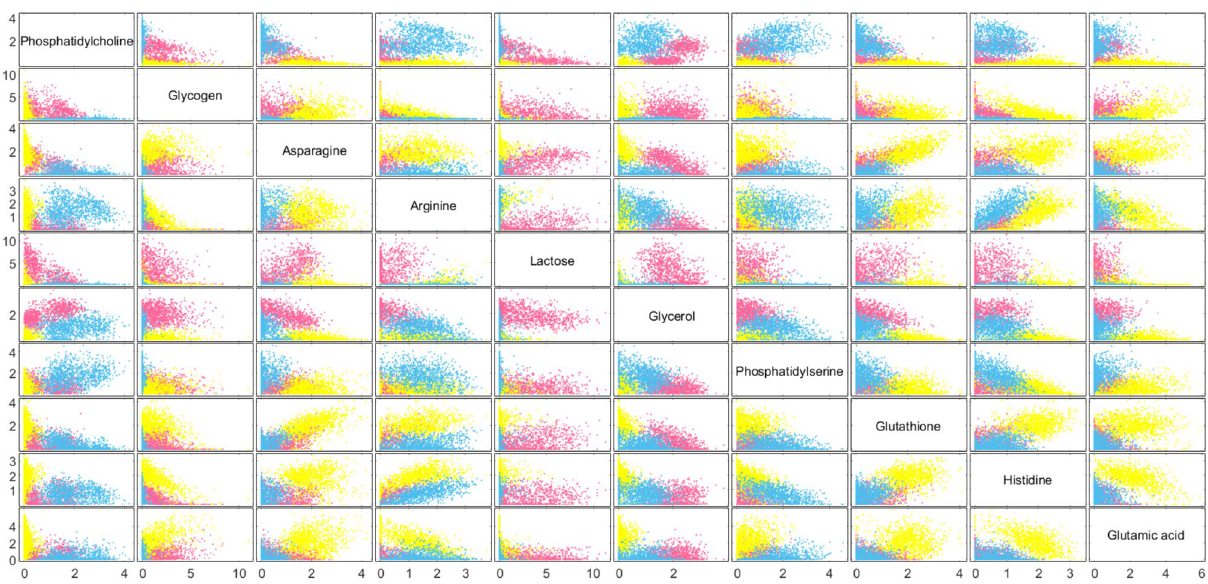
Figure 5. Scatter plot depicting scores for each cell line H460 (pink), MCF7 (yellow) and LNCaP (blue) on the 10 most important chemicals obtained from random forest decision modelling (Fig 4A), as labelled in the diagonal.